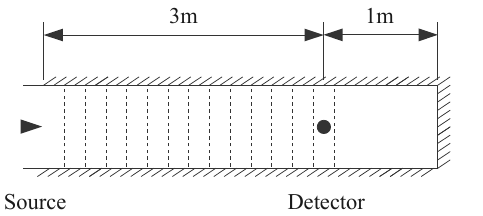
Fig. 3. Water box simulation system.